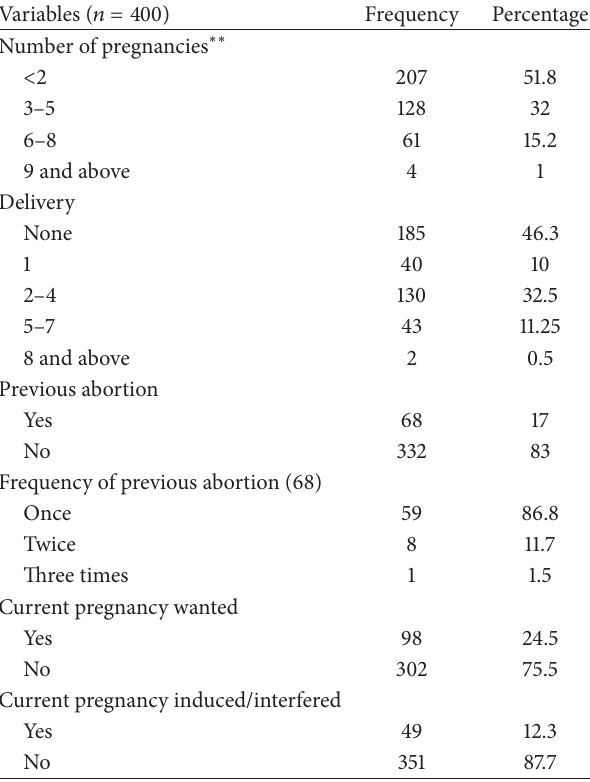
Table 2: Reproductive history of postabortion clients in health institutions of Guraghe zone, South Ethiopia, from January to March, 2010.